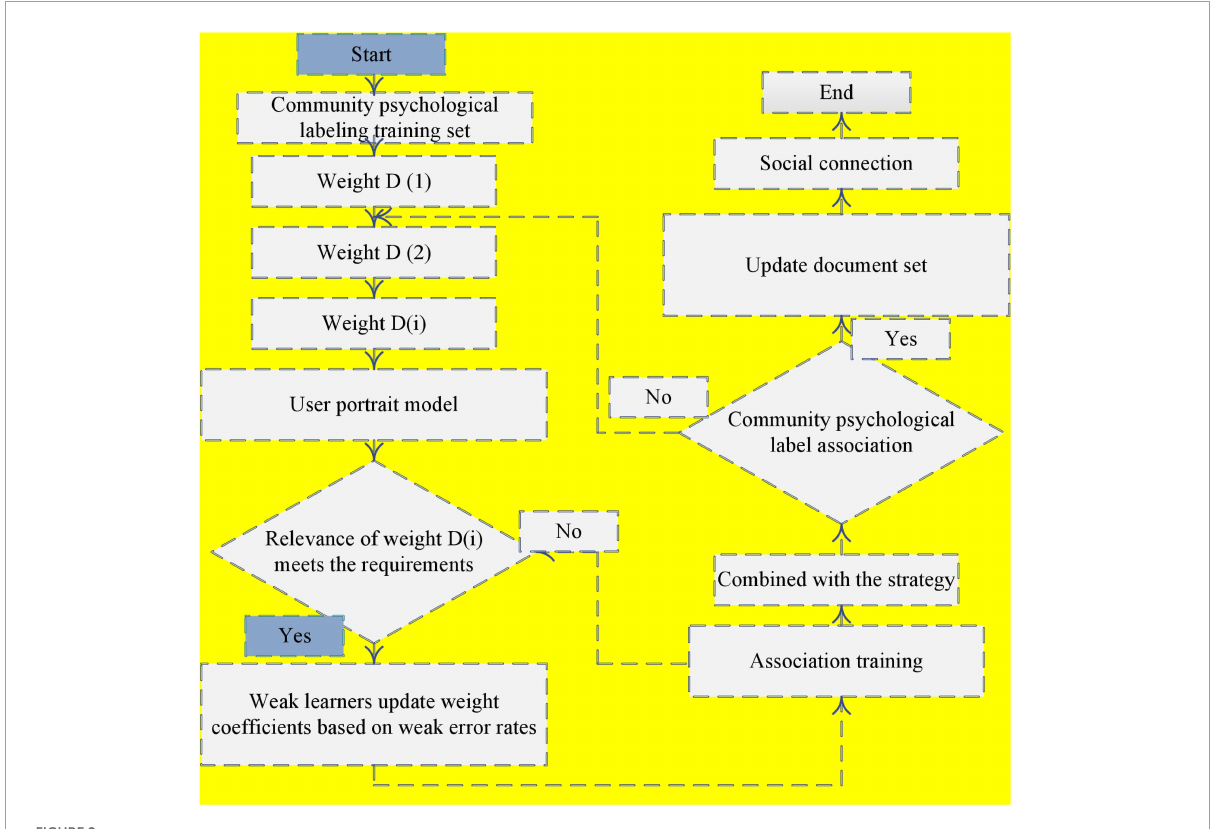
FIGURE2 Block diagram of association between community psychological label and user portrait